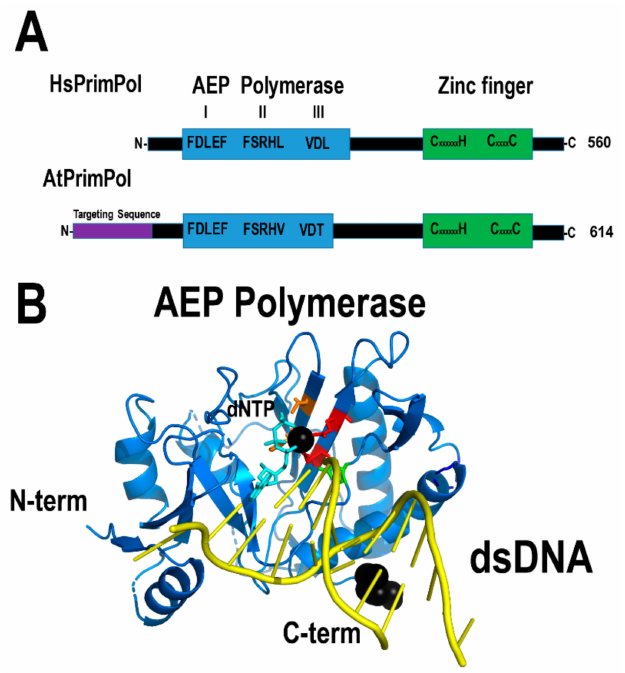
Figure 13. AtPrimPol resembles HsPrimPol. ( A ) Both AtPrimPol and HsPrimPol share a modular organization. AtPrimPol contains an N-terminal sequence for dual organellar targeting. ( B ) Structural model of the archaeo-eukaryotic primase (AEP) domain of AtPrimPol. The structural model was constructed with basis on the crystal structure of the AEP domain of